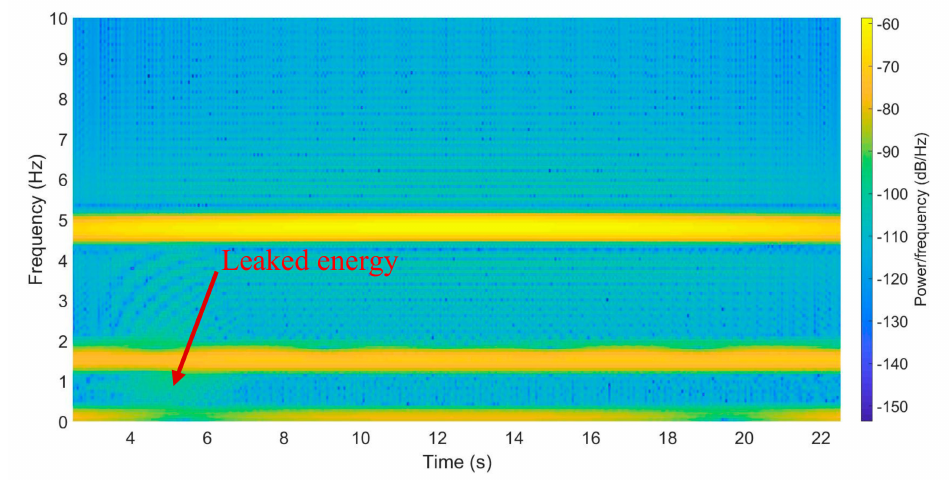
Figure 8. Short-time Fourier transformation of the bridge accelerations with damage at 5 m